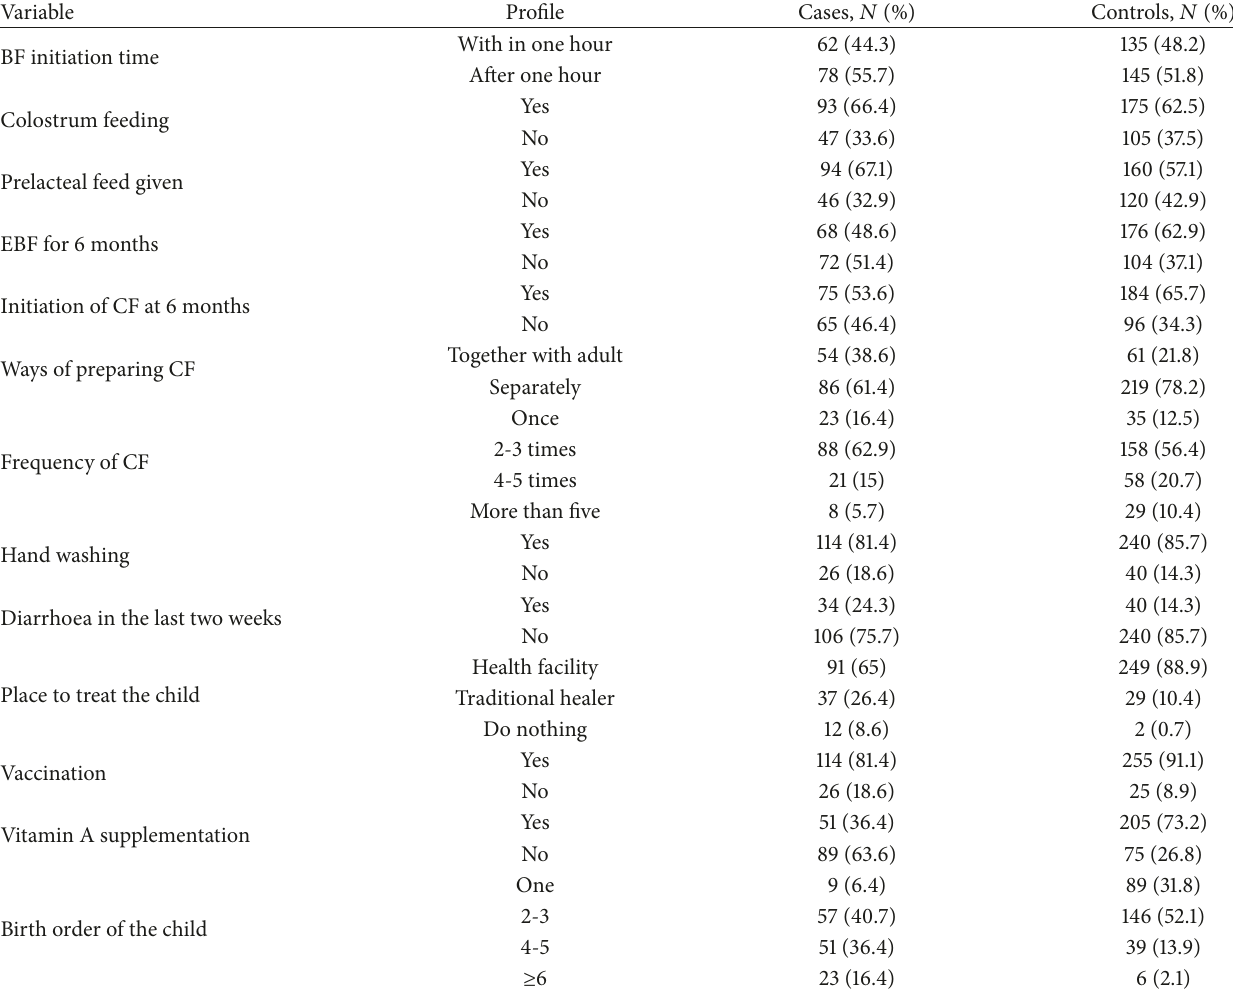
Table 2: Child feeding practice of cases and controls from Dubti District, Afar Regional State, Northeast Ethiopia, January 2014 (cases: 𝑁 = 140 and controls: 𝑁 = 280 ).